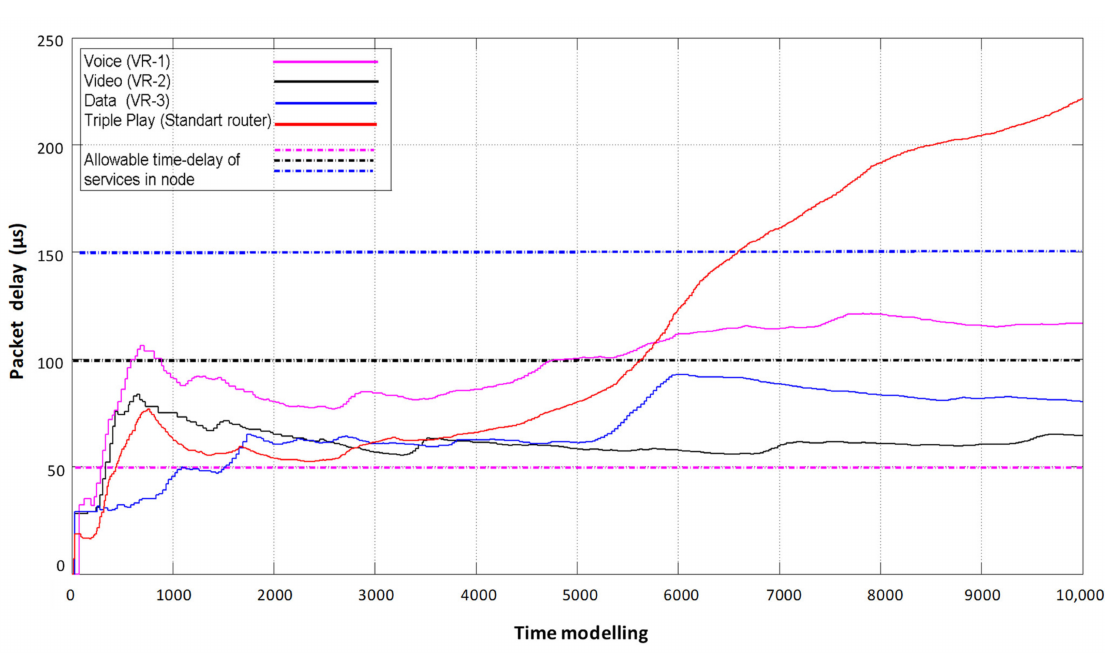
Figure 6. Comparison of packet delay times in a router without virtualization and with static virtualization of network device